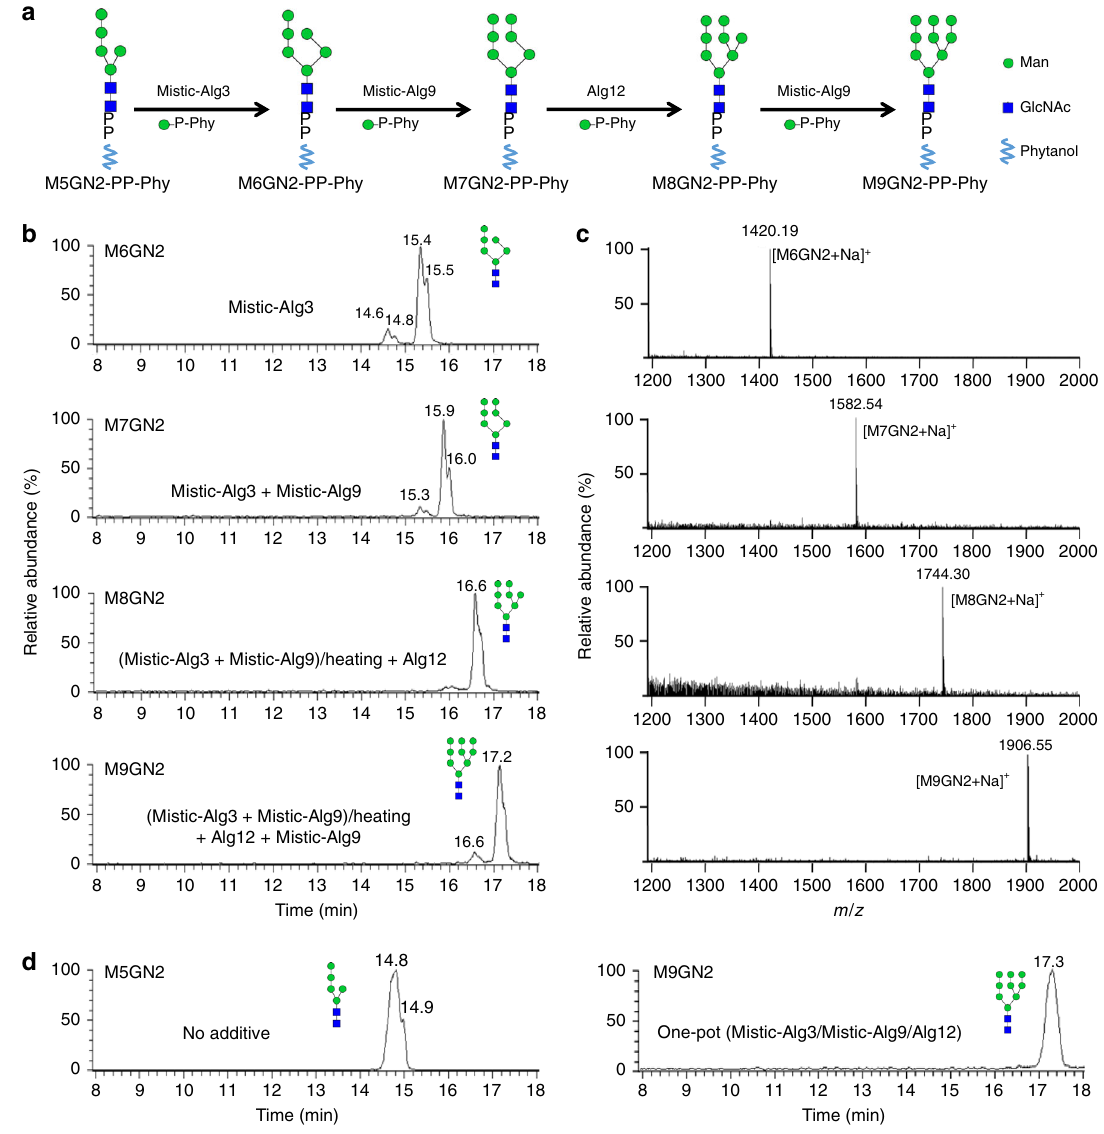
Fig. 3 In vitro assembly of the M9GN2-PP-Phy. a Schematic diagram of sequential mannosylation reactions catalyzed by Mistic-Alg3, Mistic-Alg9, and Alg12. b UPLC chromatograms of hydrolyzed glycans from reactions with various combinations of membrane fraction puri fi ed from E. coli expressing either Alg3, Alg9, or Alg12. In the presence of M5GN2-PP-Phy and Man-P-Phy, addition of Mistic-Alg3 produced M6GN2 (Mistic-Alg3); sequential addition of Mistic-Alg3 and Mistic-Alg9 produced M7GN2 (Mistic-Alg3 + Mistic-Alg9); the reaction with Mistic-Alg3 and Mistic-Alg9 was stopped by heating, then adding Alg12 produced M8GN2 [(Mistic-Alg3 + Mistic-Alg9)/heat + Alg12]; sequential addition of Mistic-Alg3 for 12 h, Mistic-Alg9 for 12 h, Alg12 for 12 h, and Mistic-Alg9 for 12 h generated M9GN2 (Mistic-Alg3 + Mistic-Alg9 + Alg12). c Mass spectra of glycans released from Phy-PP-linked oligosaccharide products. Mass analyses showed the peaks eluted ( b ) at ~15.5, ~16.0, ~16.6, and ~17.2 min correspond to M6GN2 ([M6GN2 + Na] + ), M7GN2 ([M7GN2 + Na] + ), M8GN2 ([M8GN2 + Na] + ), and M9GN2 ([M9GN2 + Na] + ), respectively. d UPLC chromatogram of hydrolyzed glycans from reactions in which Mistic-Alg3, Mistic-Alg9, and Alg12 were added simultaneously for 20 h in one pot to generate M9GN2 from M5GN2-PP-Phy and